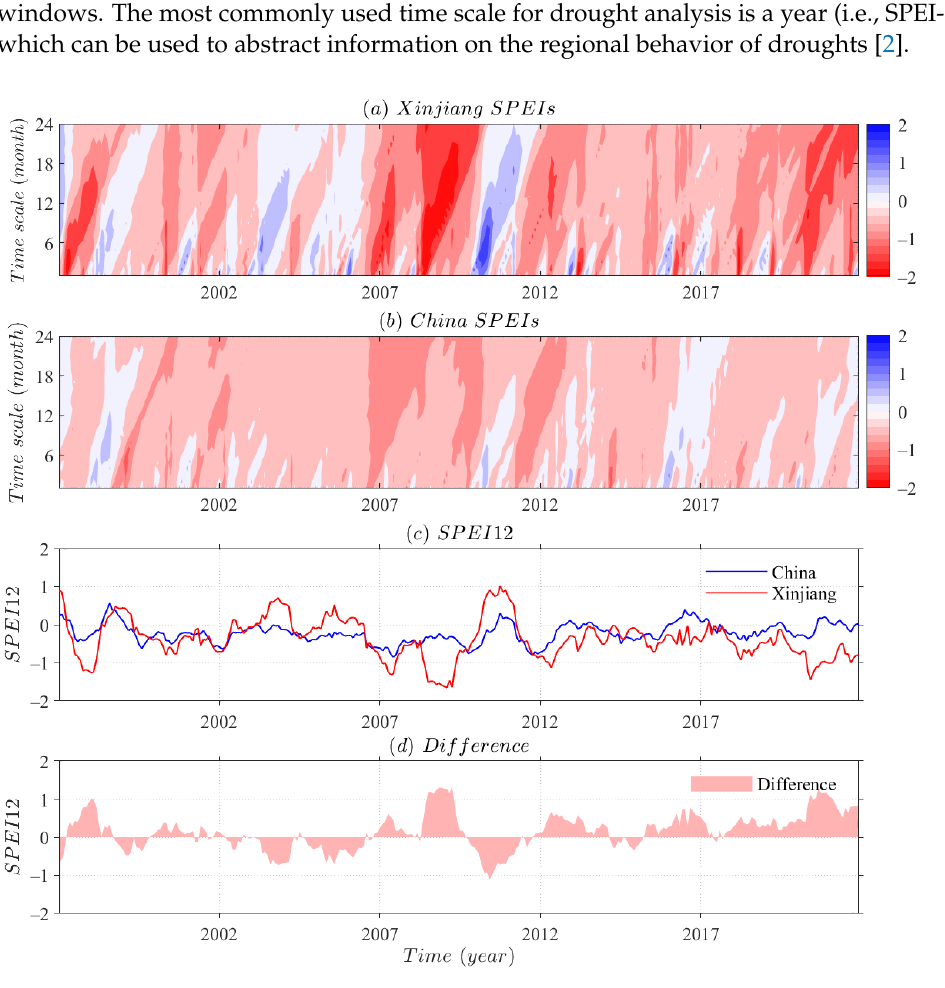
Figure 2. Monthly SPEI time series during the period of 1997 to 2021 for ( a ) Xinjiang region and ( b ) Chinese territory on 1- to 24-month time windows; ( c ) SPEI-12 time series of China and Xinjiang region; and ( d ) the difference value between China SPEI-12 and Xinjiang SPEI-12, where the upper (lower) horizontal axis denotes the drought in Xinjiang region is stronger (weaker) than the average state of drought in